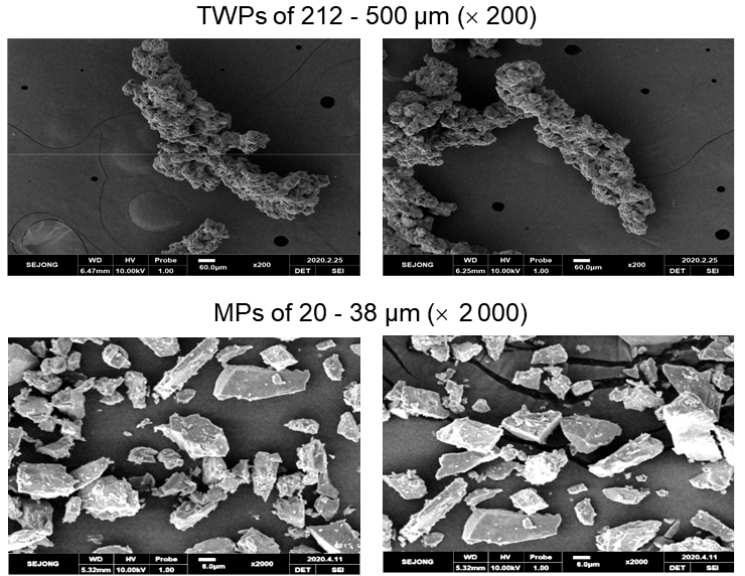
Figure 1. SEM images of the model TWPs of 212–500 μ m and the model MPs of 20–38 μ m. The scale bars are 60 and 6 μ m for the magnifications of 200 and 2000, respectively.